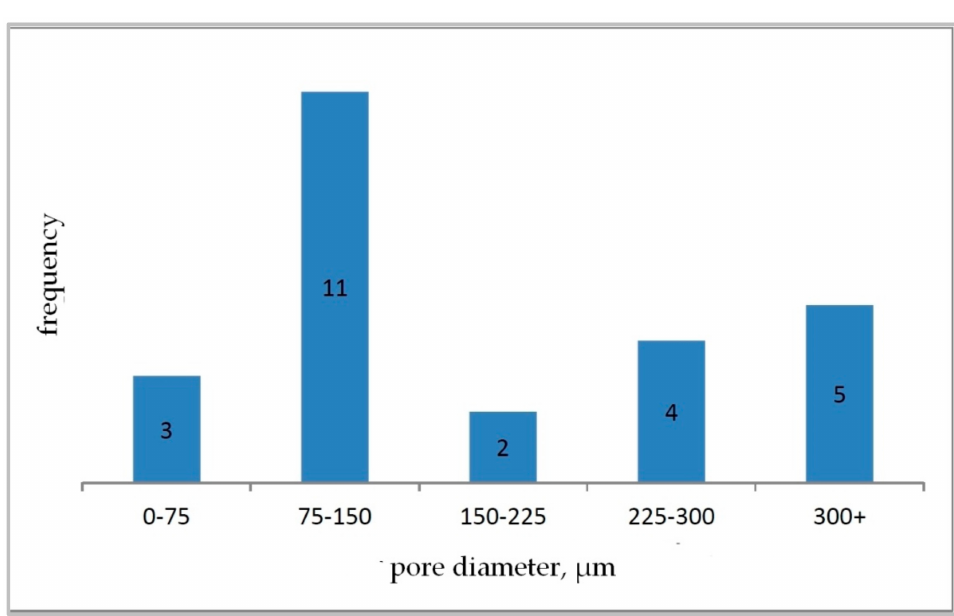
Figure 12. Pore size histogram for carbon sample M2.